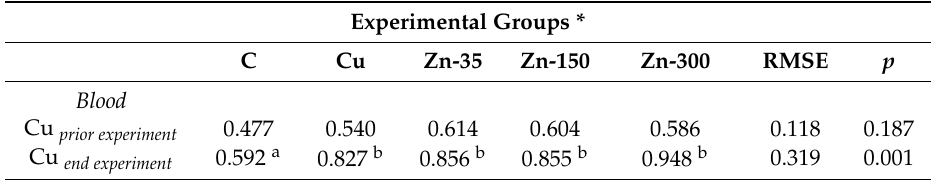
Table 1. Cu and Zn mean concentrations in blood (mg/L), liver (mg/kg fresh weight), and bile (mg/L) in the experimental groups before and at the end of the